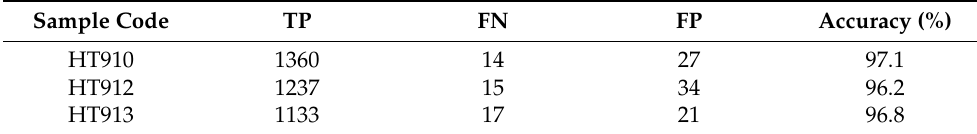
Table 3. The extraction results of dendrite cores of three additional